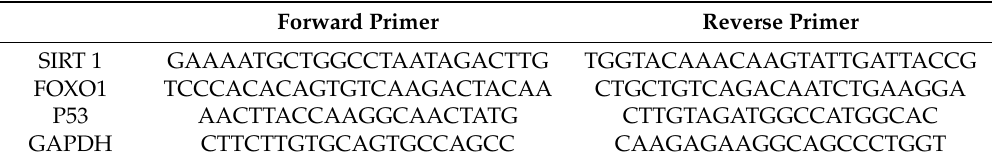
Table 2. Primer sequences used for semi-quantitative RT-qPCR